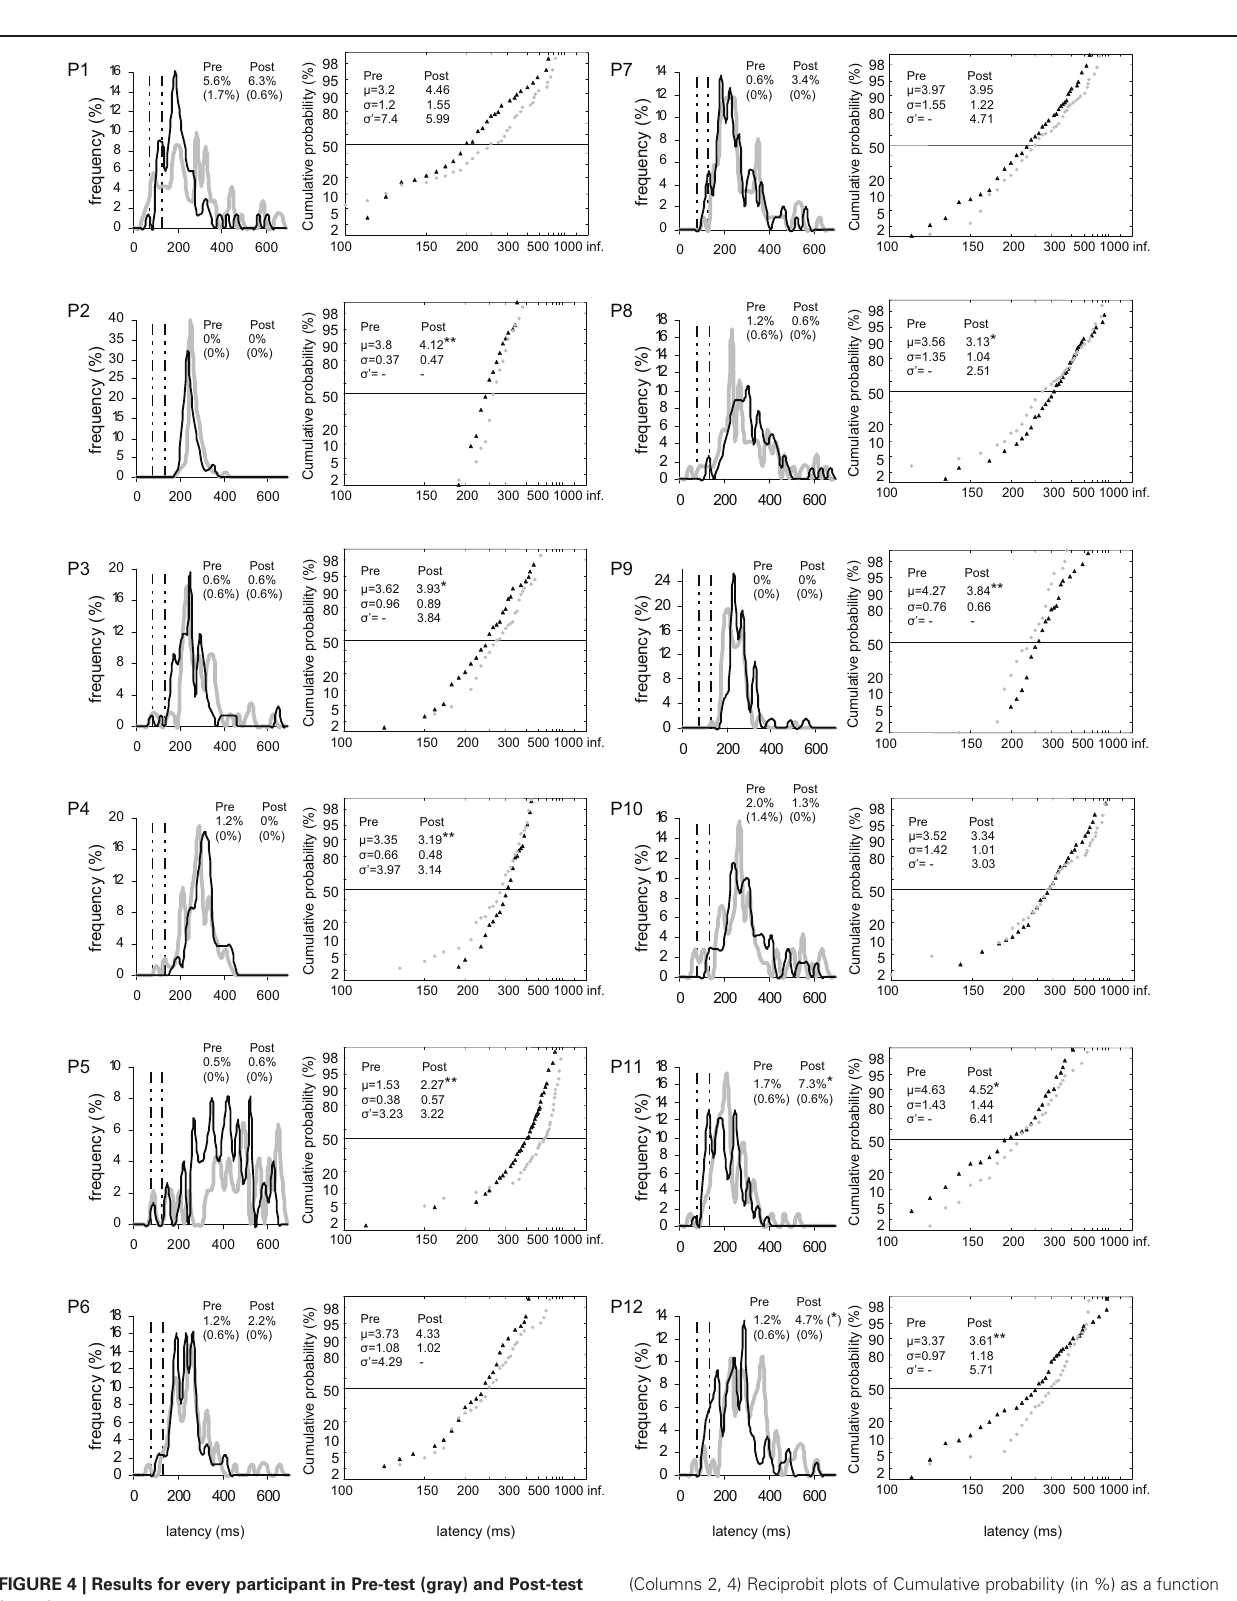
(Columns 2, 4) Reciprobit plots of Cumulative probability (in %) as a function of Latency (in ms) for saccades between 80 and 999ms in valid direction, and μ , σ , and σ (cid:4) values. N = 47–100 in frequency histograms and reciprobit plots. Other notations as in Figure 3